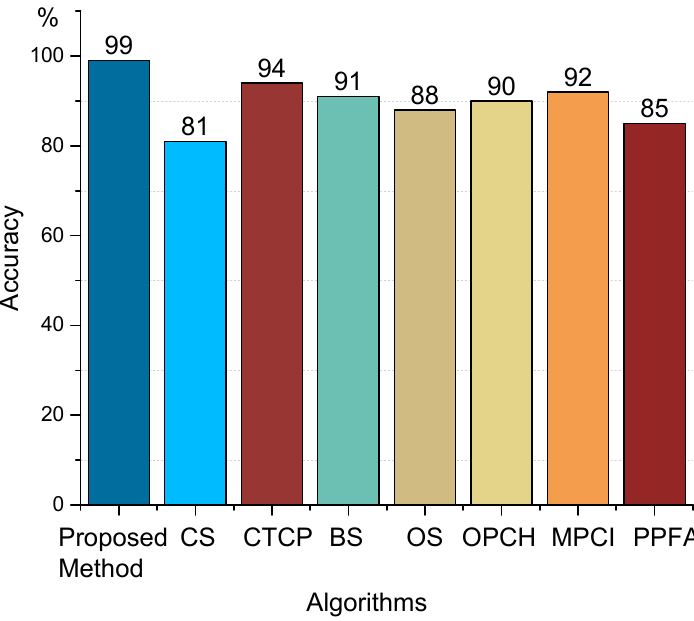
Figure 18. Identification accuracy of different algorithms.